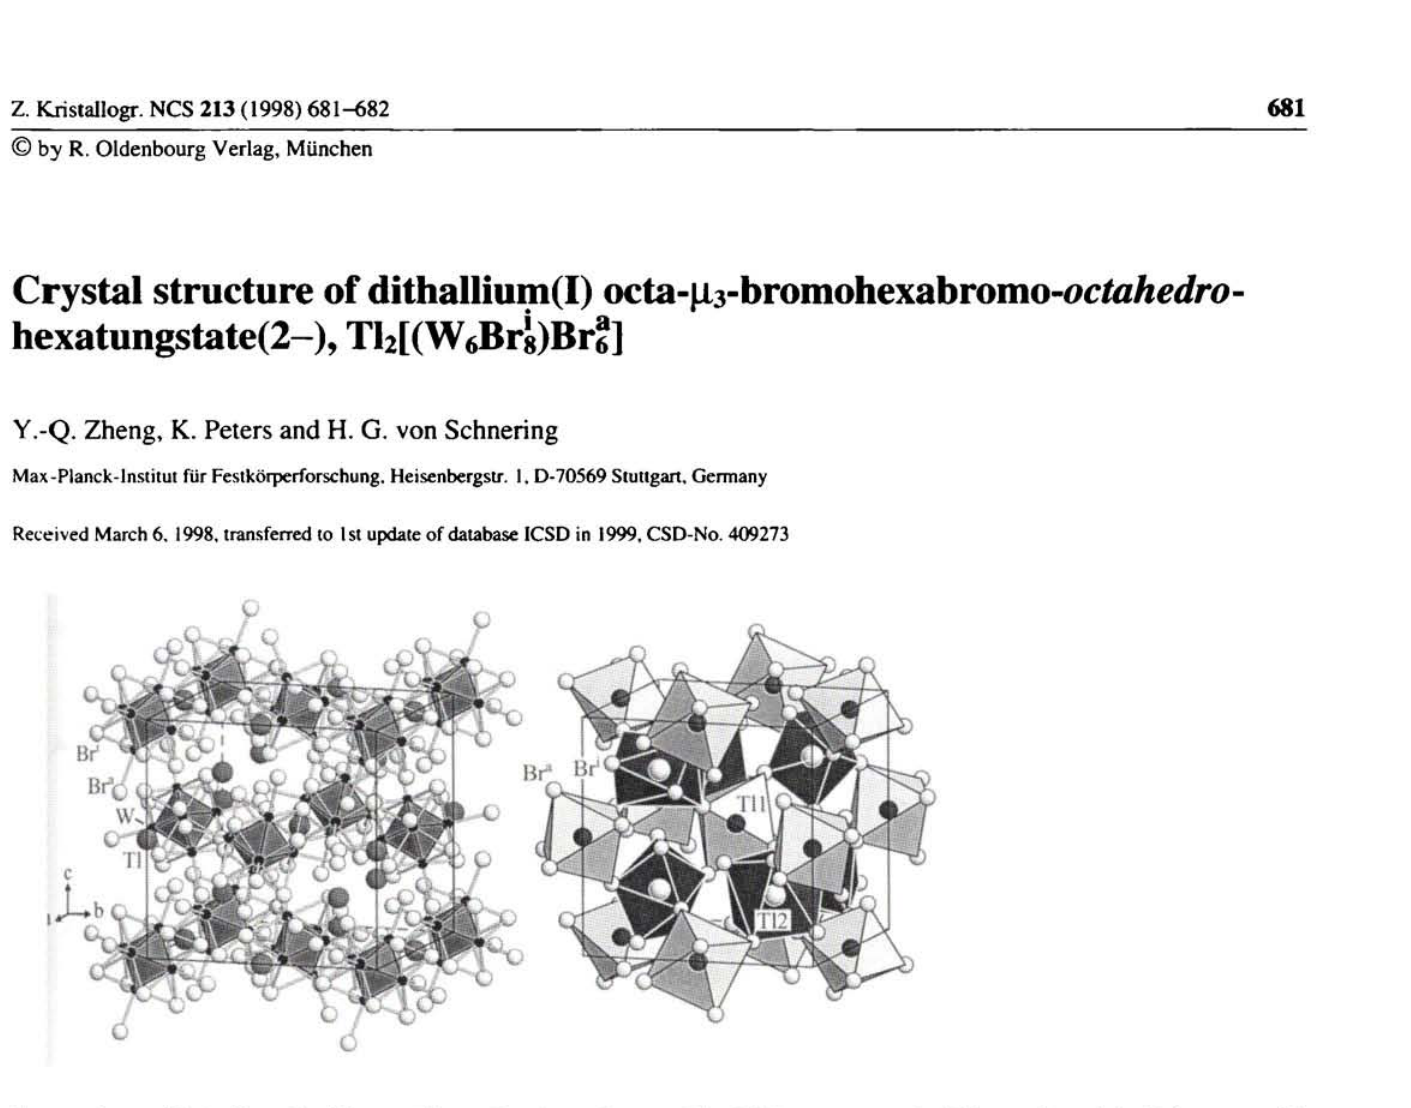
The Tl(l) atoms are sixfold coordinated by Br" atoms with ¿(Tl-Br) = 3.315 Â (6x), while Tl(2) eightfold coordinated by Br® and Br* atoms with </(Tl-Br) = 3.245 Â (4x) and 3.465 Â (4x), respectively. Bn4Tl2W6, cubic, Pre (No. 201), a =13.873(2) Â,